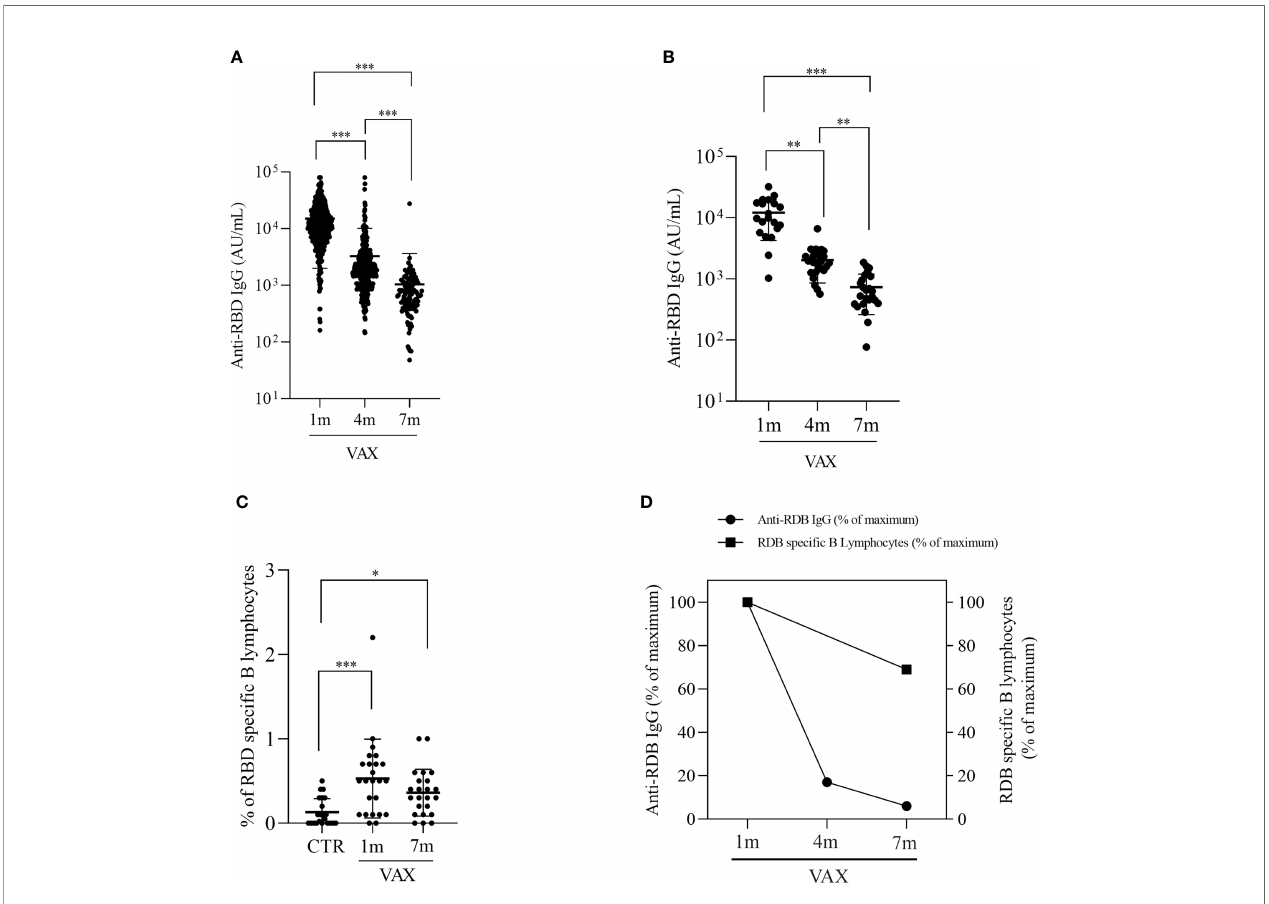
FIGURE 1 | Analysis of anti RBD speci fi c IgG levels and RBD speci fi c B lymphocytes in immunized subjects. (A) Concentration of anti-RBD IgG at 1, 4 and 7 months post second dose vaccination in the HCW cohort. Data were were analyzed by repeated-measurement two-way ANOVA and Bonferroni ’ s multiple comparison test. A two-sided p < 0.05 was considered statistically signi fi cant. (B) Concentrationof anti-RBD IgG at 1-, 4- and 7- months post vaccination in the subgroup of subjects that were analyzed also for cellular populations. Differences were analyzed with Friedman test and Dunn ’ s multiple comparison test. (C) comparision of circulating RBD speci fi c B lymphocytes in not immunized controls (CTR) and in vaccinated subjects at 1 and 7 months, measured by fl ow cytometry. (D) comparision between the decline in anti-RBD IgG levels and in RBD speci fi c B lymphocytes. Results are expressed as percentage of initial measured levels. *p < 0.05 **p < 0.01. ***p <